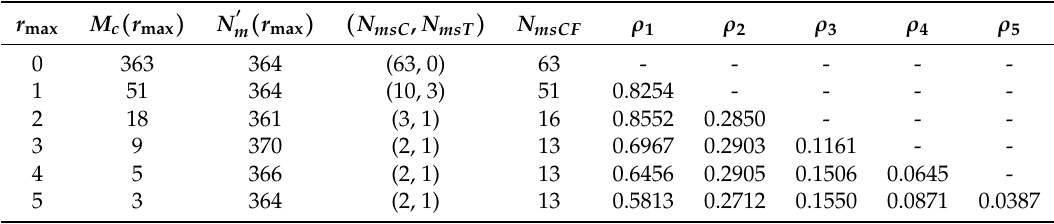
Table 7. Parameters, N m = 364; p act = 0.001; ( N intra , N inter ) ∗ = ( 3,7 ) ; N msCF = N msC . N intra +